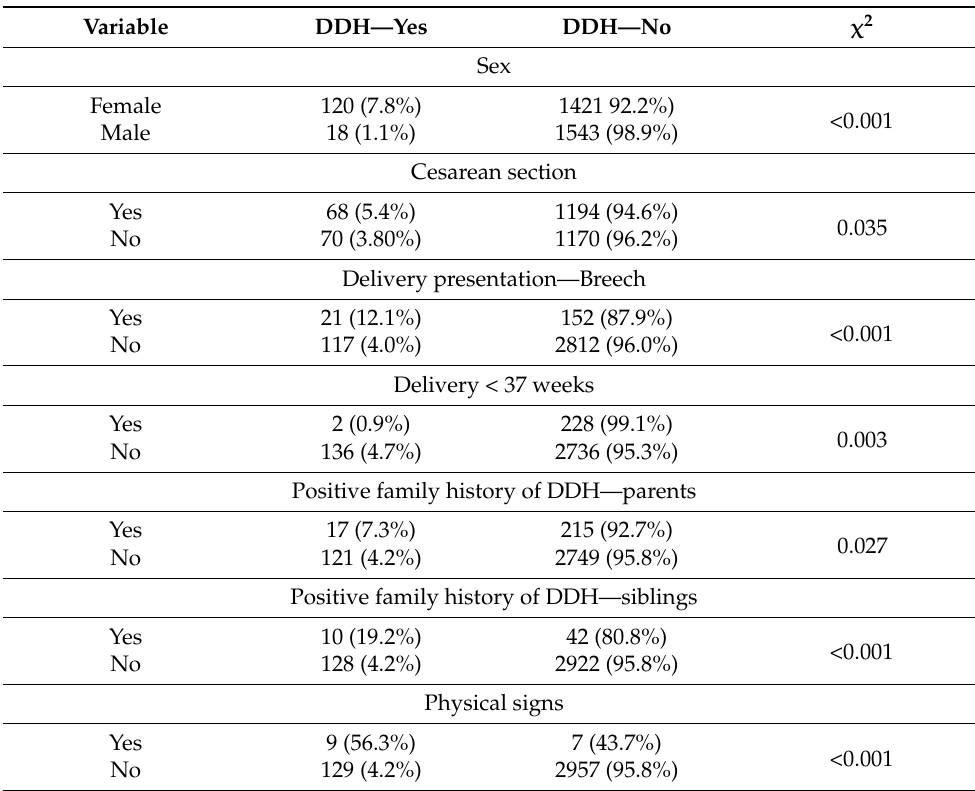
Table 2. Risk factors of developmental dysplasia of the hip